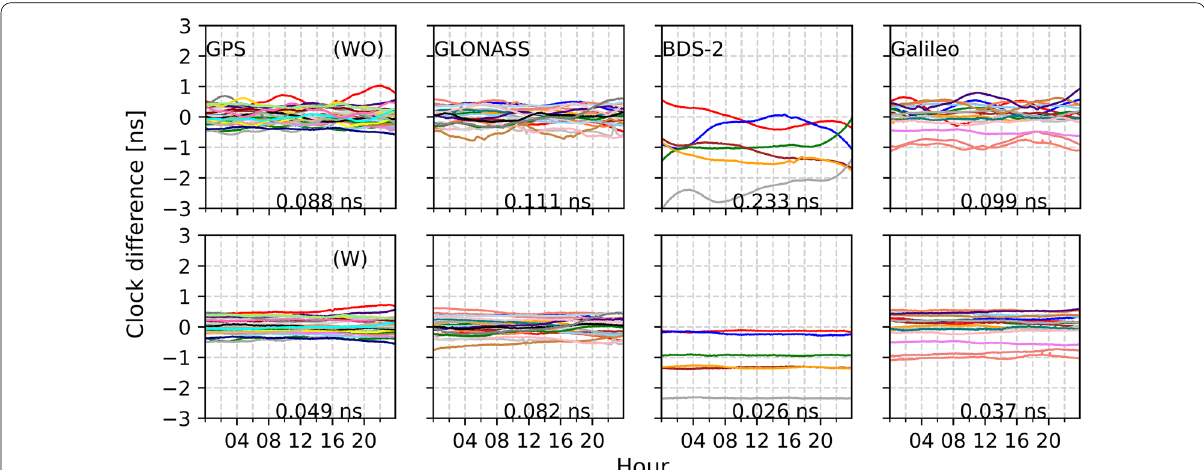
Fig. 1 Inter-satellite and inter-AC clock differences of the ESM and COM solutions without (WO) and with (W) the frame correction for the first day of 2018. Different colors are used for line plots to indicate individual satellites and the values in black are the mean STDevs for each